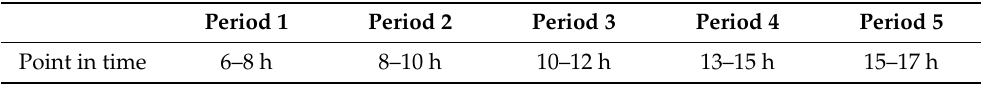
Table 1. Division of the five scheduling